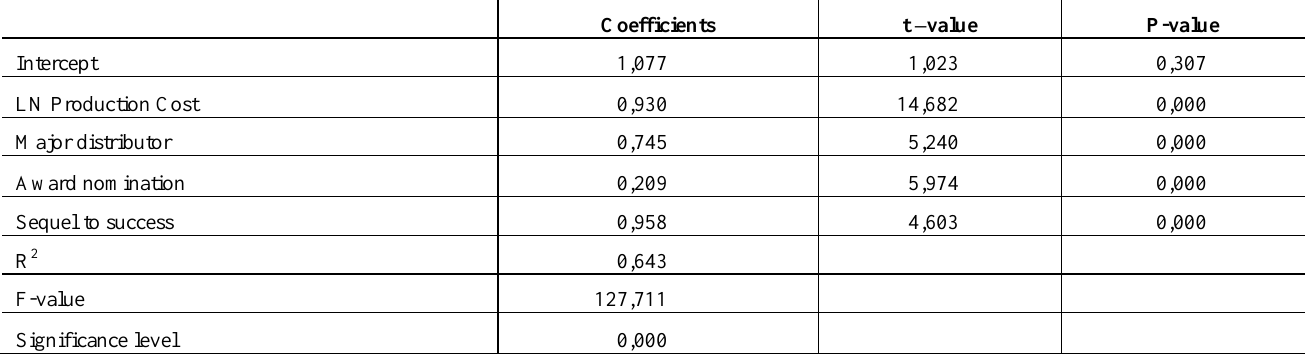
Table 3: Determinants of revenue